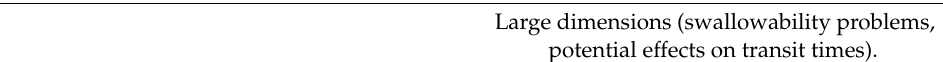
Table 7. Advantages and limitations of telemetric capsules. Advantages Limitations Move freely within the GI tract. Drift of pH sensors is common. Minimally invasive. Single-use systems. Measurements with high temporal resolution. Lack of tracking. Large dimensions (swallowability problems, potential effects on transit